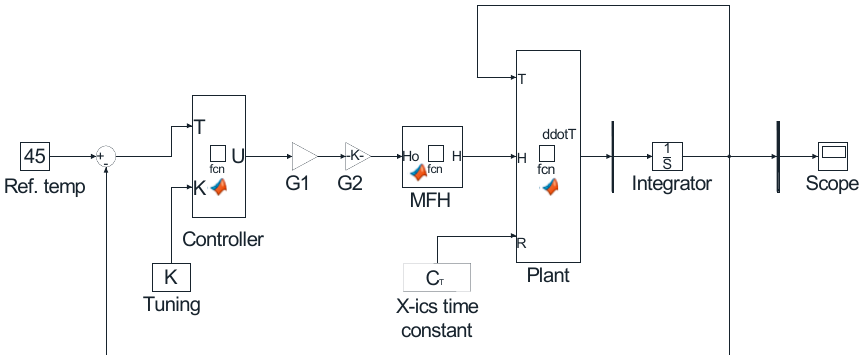
Figure 9. Simulink model with pole placement controller.